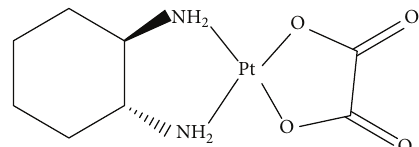
Figure 1: Molecular structure of OXPt (MW = 397.29